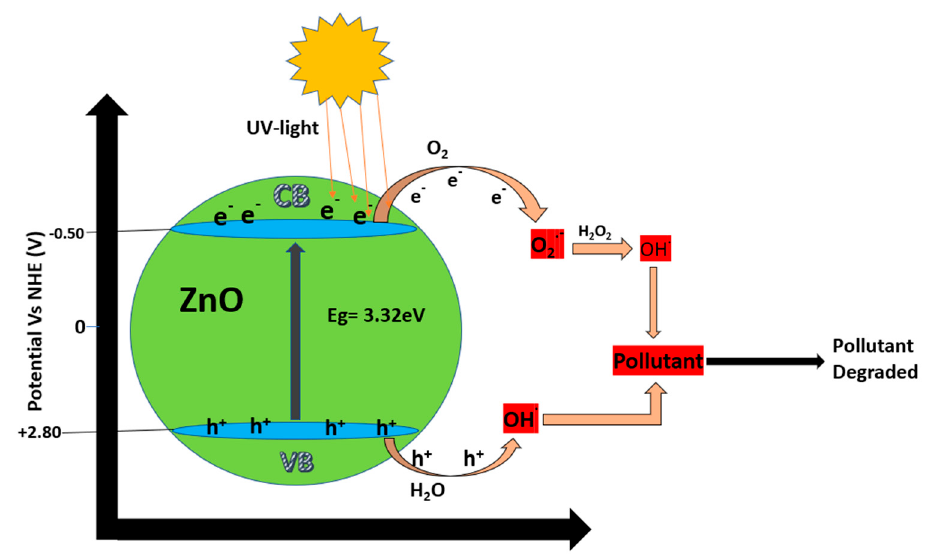
Figure 1. Photocatalytic mechanism of ZnO in wastewater.